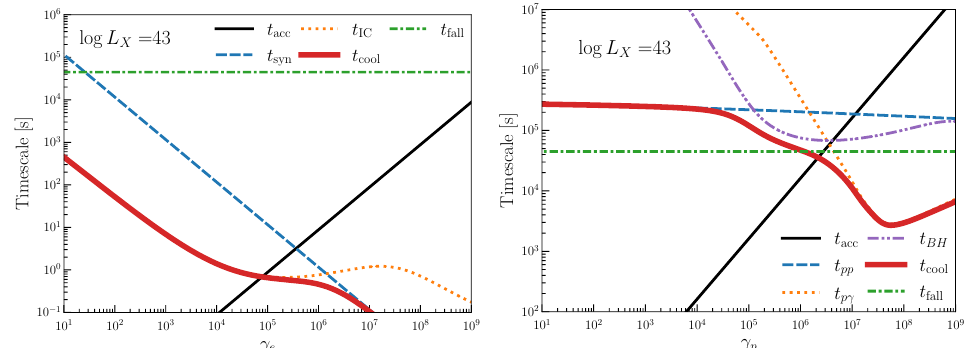
Figure 7. ( Left ) Electron energy losses in AGN coronae together with acceleration and dynamical timescales for L X = 10 43 erg s − 1 . Thin solid line shows the acceleration timescale assuming DSA. Dashed, dotted, and thick solid curves correspond to synchrotron cooling, IC cooling, and total cooling timescales, respectively. The dot-dashed curve shows the free-fall timescale. ( Right ) Same as in the ( Left ) panel, but for protons. Dashed, dotted, double-dot-dashed, and thick solid curves correspond to pp cooling, p γ cooling, Bethe–Heitler cooling, and total cooling timescales, respectively. For both panels, different luminosity cases are shown in Inoue et al.